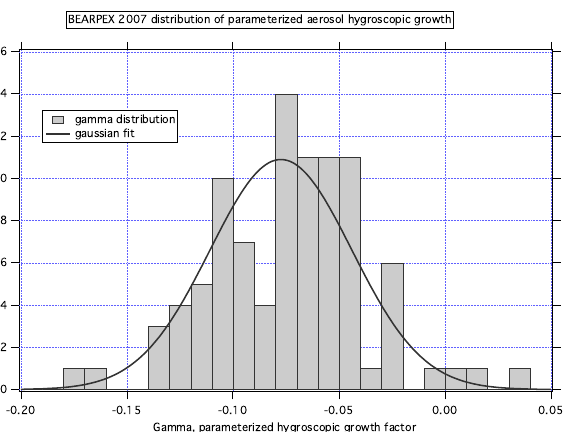
Fig. 4. Mean aerosol size distribution from the OPC during